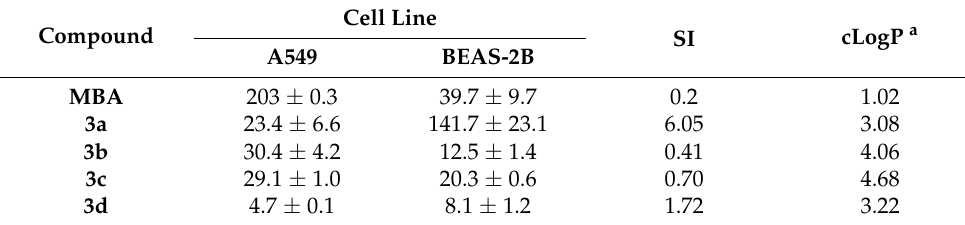
Table 3. Selectivity of MBA and compounds 3a – d in NSCLC cell line A549 and normal bronchial epithelium cell line BEAS-2B .